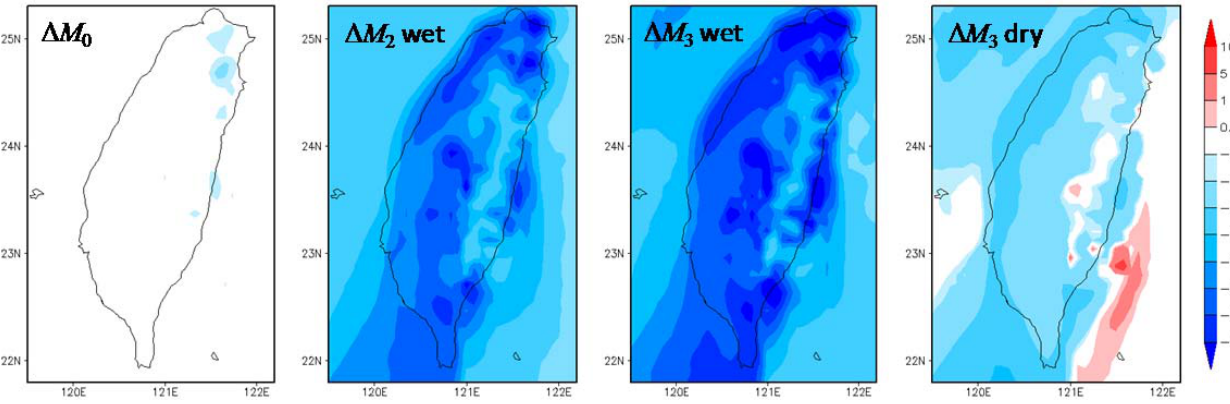
Figure 15: Changes in aerosol moments due to the inclusion of Kelvin effect. Panels from left to ), surface area of wet particles (  M wet), volume of wet right are percent change in number (  M 0 2 particles (  M wet), and volume of dry particles (  M 3 3